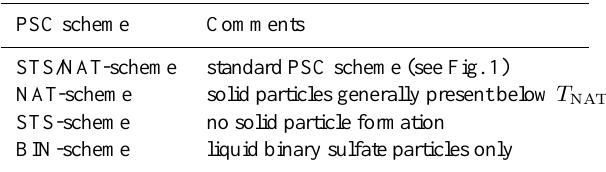
Table 5. PSC schemes applied (see text for details) PSC